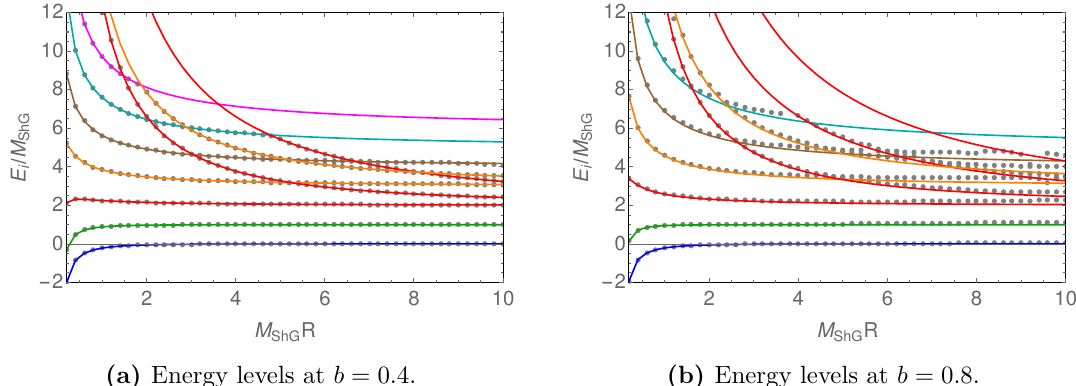
Figure 9. Here we present TSM data (dots) for the first 8 energy levels after N c extrapolation as functions of the dimensionless volume M ShG R in the zero momentum sector. The vacuum energy E 0 is subtracted and energies are normalized with respect to the mass M ShG . The color coding of the TBA (solid) curves is as follows: the ground state is depicted in blue, the one-particle state in green, two-particle states in red, three-particle states in orange, four-particle states in brown, five-particle states in teal, and six-particle states in